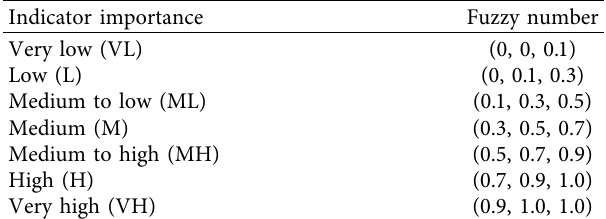
Table 2: Scoring criteria for the fuzzy weight of indicators. Indicator